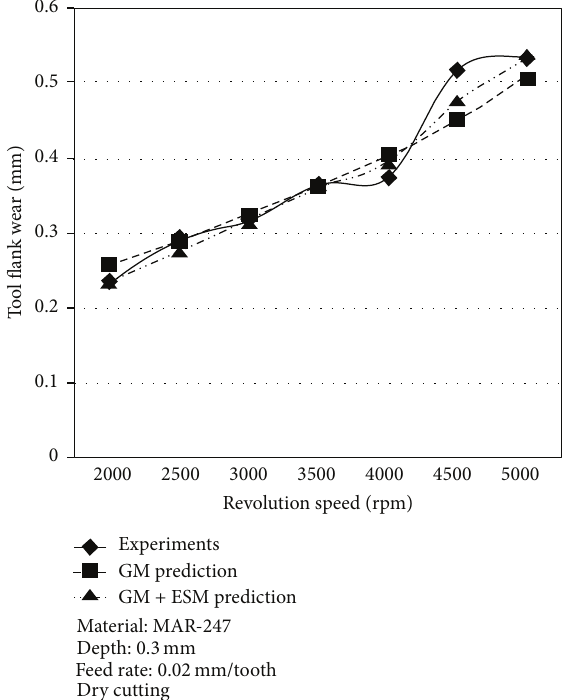
Figure 5: Relationships between revolution speed of main shaft and tool wear